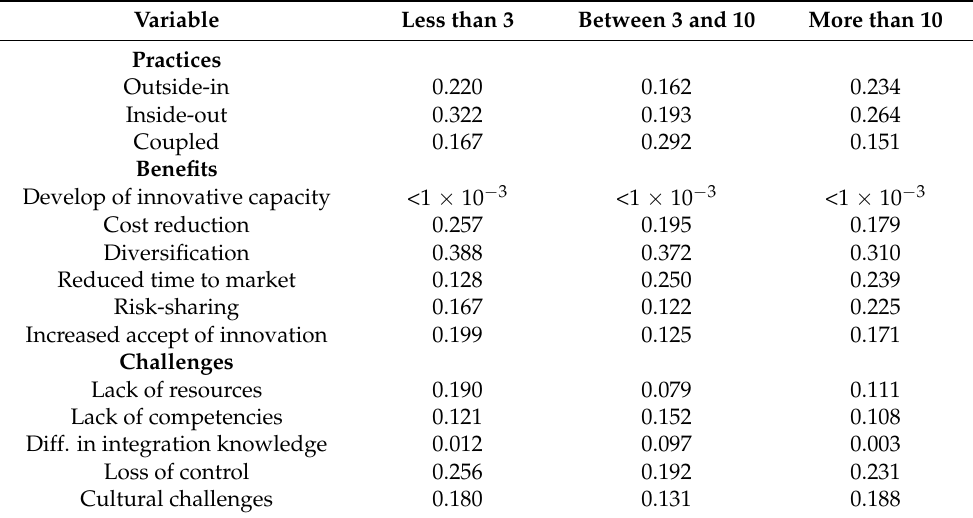
Table 7. ANOVA analysis for the number of years of